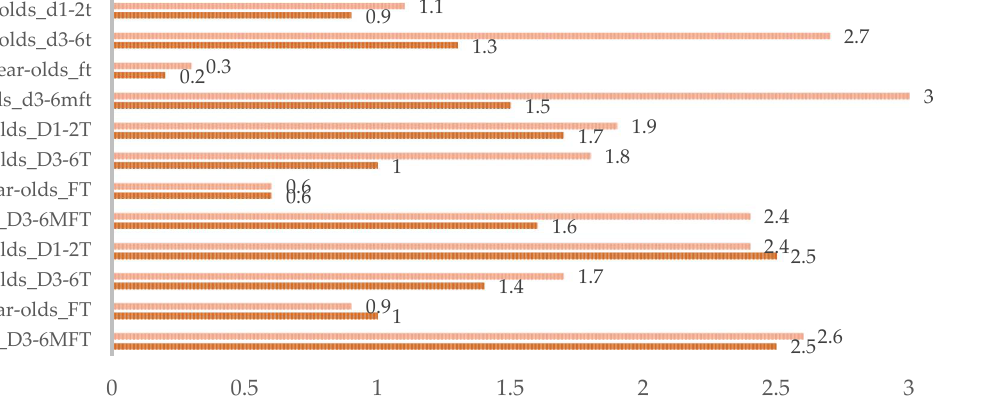
Figure 2. Caries experience of 5-, 12- and 15-year-old children and adolescents of immigrant origin in Greece, compared with their Greek age-mates. Mean ICDAS 1–2 at the tooth level (d 1–2 t/D 1–2 T), mean d 3–6 mft/D 3–6 MFT, mean d 3–6 t/D 3–6 T and mean ft/FT. * p ≤ 0.05, ** p ≤ 0.01 and *** p ≤ 0.001, as analysed by the Mann–Whitney U-test. Caries estimates of the Greek 5-, 12- and 15-year-olds were adapted from Diamanti et al. (2021) [11].